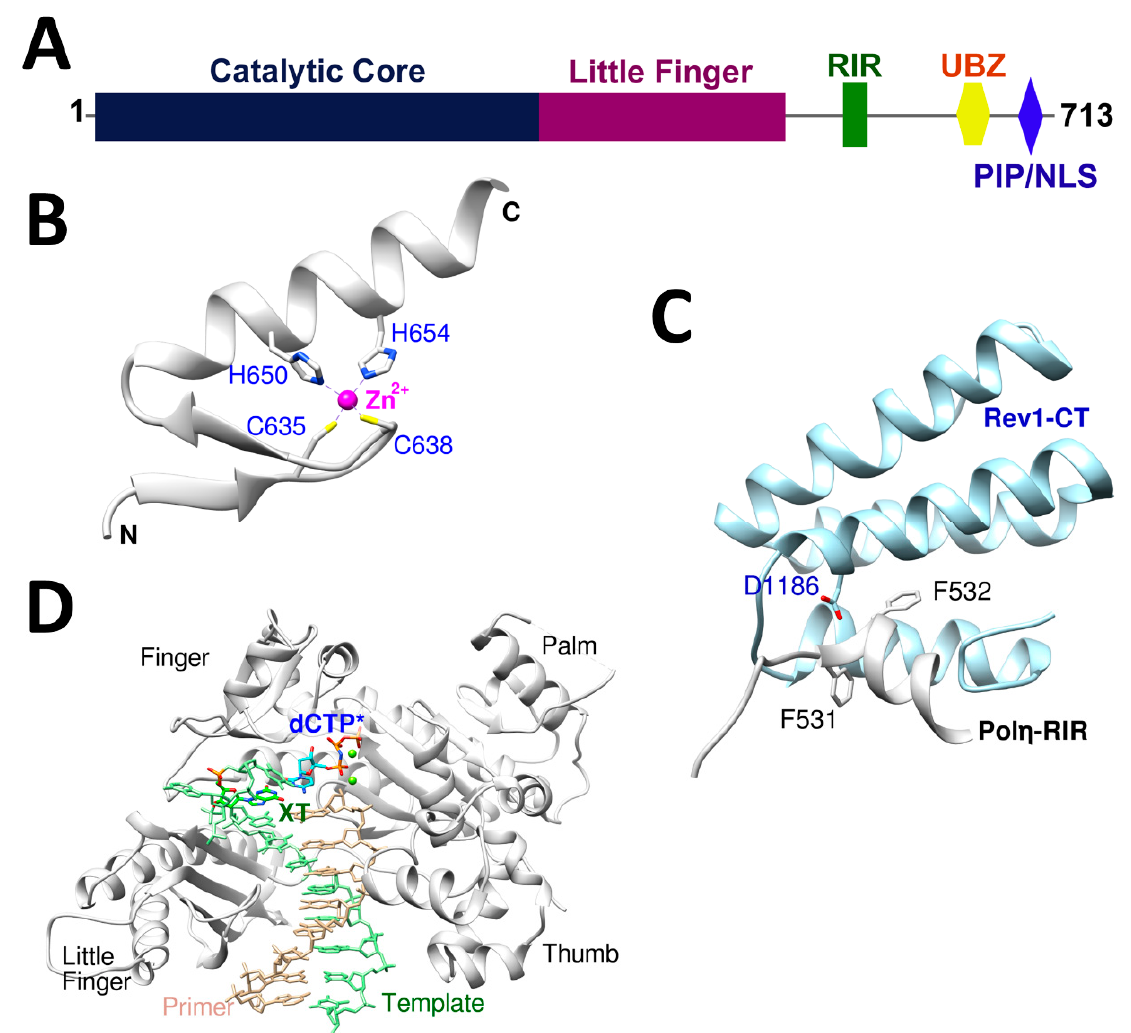
Figure 1. Structure of human pol η . ( A ) The schematic diagram of the overall structure of pol η . The N-terminal catalytic core including little finger domain and the C-terminal binding/regulatory domains including RIR, UBZ, PIP, and NLS are shown. ( B ) The crystal structure of UBZ domain of pol η (PDB ID: 3WUP). Two catalytic histidine residues and two cysteine residues coordinating Zn 2+ ion are shown. ( C ) The NMR structure of Rev1 interacting region (RIR) of pol η complexed with Rev1 C-terminus region (Rev1-CT) (PDB ID: 2LSK). The two crucial phenylalanine residues of pol η and aspartate residue of Rev1 are shown. ( D ) The overall structure of pol η catalytic domain complexed with xanthine (XT) and the incoming dCTP* (PDB ID: 6WK6). All the conserved domains, finger, palm, thumb, and little finger, are shown. Figures in this review were prepared using Chimera